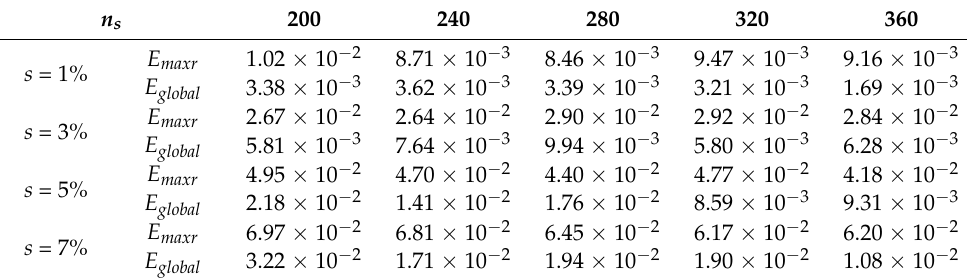
Table 2. The numerical errors of different number of local nodes.